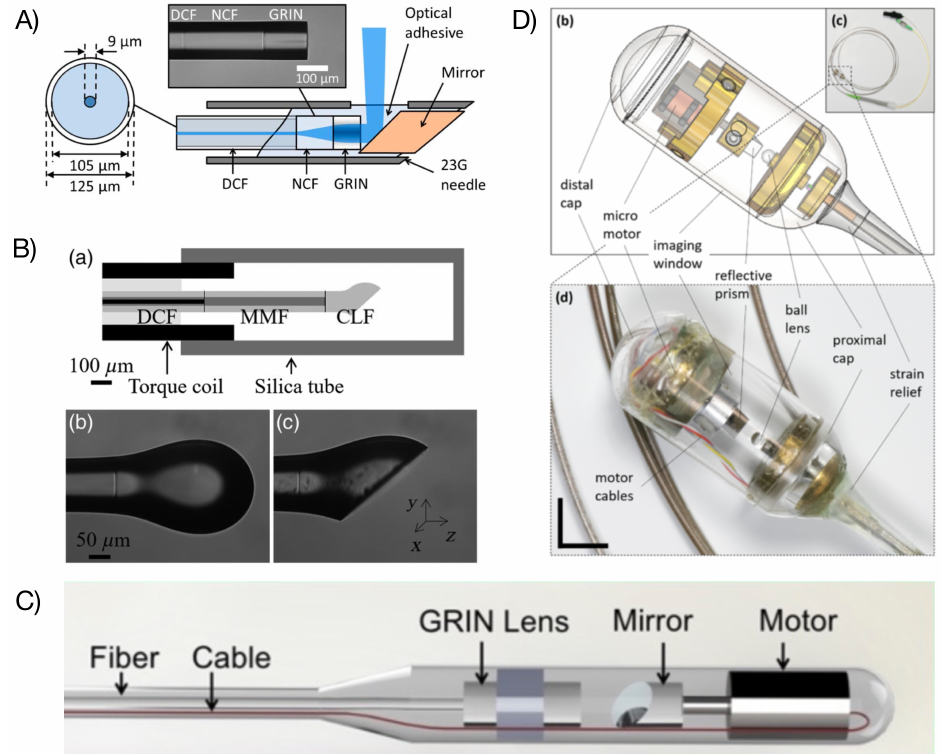
Figure 2. DCF-based probes and catheters. ( A ) Monolithic all-fiber needle probe [25]; ( B ) monolithic ball lens-based probe [41]; ( C ) micro-motor-based probe [36]; ( D ) capsule catheter [42]. Images reprinted with permissions from refs. [25,36,41,42]. Copyright 2013, 2019, 2021 Optica and 2020